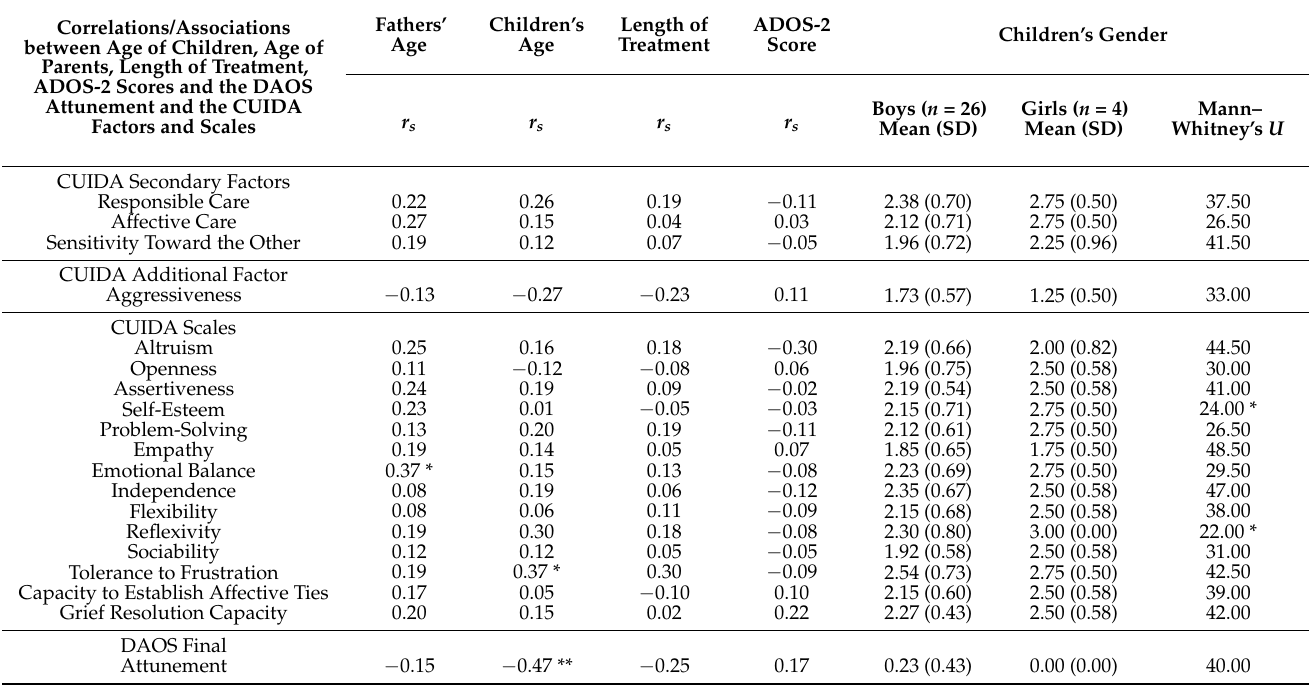
Table 4. Correlations/associations between age of children, age of parents, length of treatment, ADOS-2 scores and the DAOS attunement and the CUIDA factors and scales. Correlations/Associations between Age of Children, Age of Parents, Length of Treatment, ADOS-2 Scores and the DAOS Attunement and the CUIDA Factors and